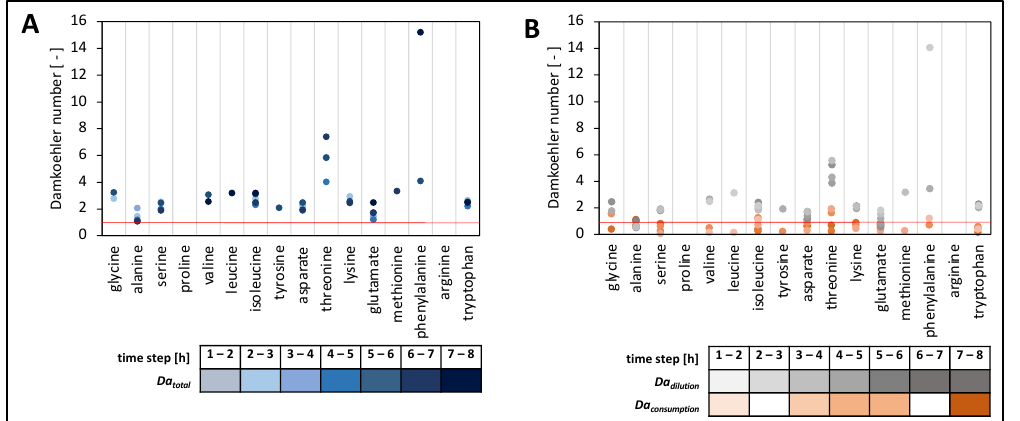
Figure 8. Damkoehler numbers ( Da I ) of individual amino acids. ( A ) Da total = Da dilution + Da consumption in the compartment containing Streptococcus thermophilus . ( B ) Da dilution + Da consumption separated in the compartment containing S. thermophilus . Strains were cultivated in the tube bioreactor system, and Da was calculated for each hour of continuous cultivation. Da numbers were only calculated if amino acid uptake was present within 1 h. The red line indicates Da = 1.